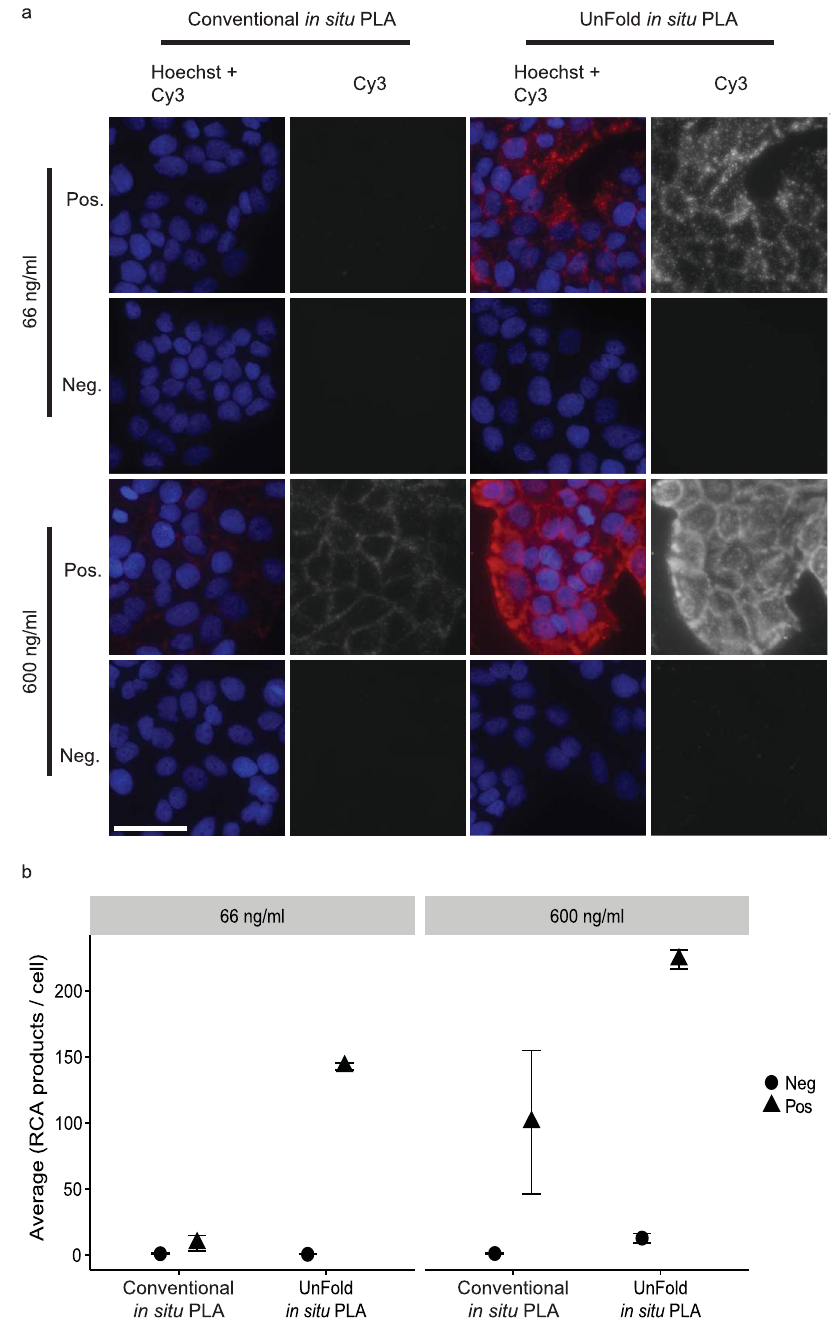
Figure 2. Visualization of E-cadherin/ β -catenin interactions in HaCat cells. ( a ) Images of cells stained with primary antibodies against E-cadherin and β -catenin and secondary conventional or UnFold in situ PLA probes recording E-cadherin/ β -catenin interactions (Pos). As a background control, primary antibodies were omitted (Neg). The RCA products were labeled with Cy3 (red dots in the merged images) and the nuclei were stained with Hoechst 33342. Scale bar (white) = 50 µ m. ( b ) Quantification of signals per cell comparing in situ PLA and UnFold at different probe concentrations. Experiments were performed three times. Three images per experimental condition were acquired. Error bars represent